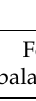
Table 1. Chemical composition of the Fe-Mn-Al-Si high manganese steel under examination. Content of Elements,